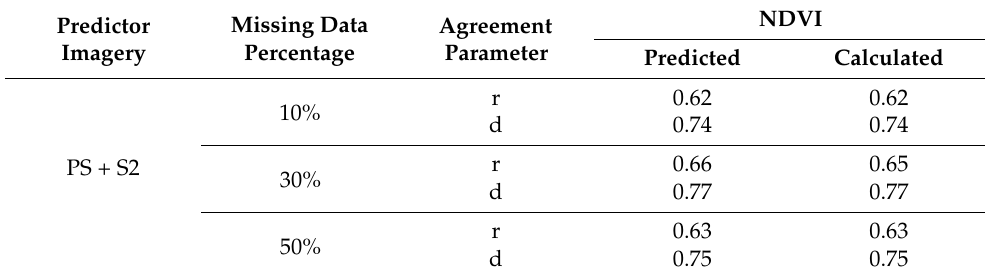
Table 3. Spatial agreement between the original, predicted, and calculated UAV NDVI images.